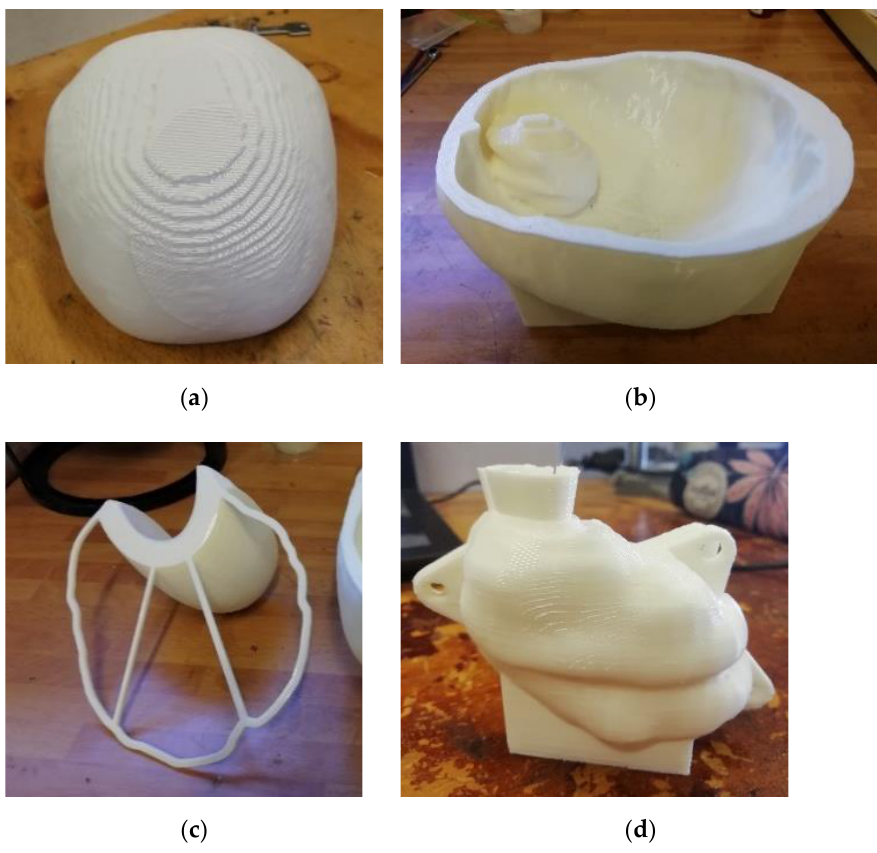
Figure 6. 3D printed skull (the visible layers were due to the slicing height of the CT scan, which was 2 mm in the vertical or z -axis) ( a ), the brain mold ( b ), the mold to define the working area inside the brain mold ( c ), and the tumor mold ( d ). Approximate dimensions: ( a ) skull with 180 mm length and 150 mm width from the top view, ( b ) brain mold with 205 mm length and 159 mm width from the top view, ( c ) mold inside brain mold with 155 mm length from the top view, and ( d ) tumor mold with 90 mm length and 70 mm width from the top view.